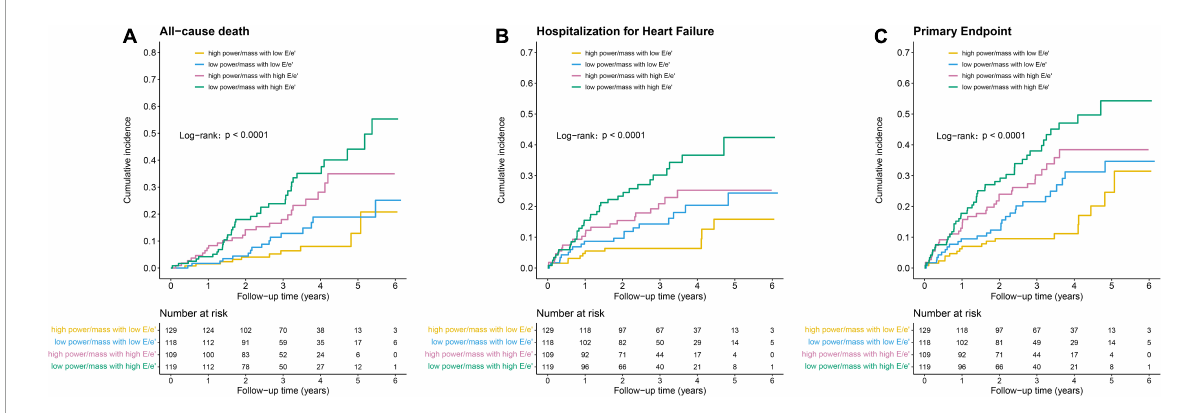
FIGURE1 Kaplan–Meier survival curves for (A) all-cause death, (B) hospitalization for heart failure, and (C) primary